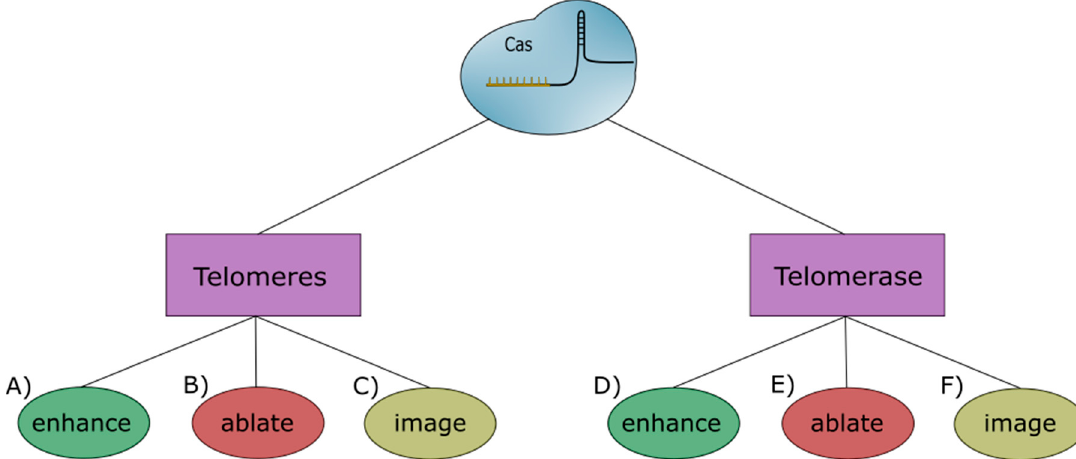
Figure 3. Overview of the uses for clustered regularly interspaced short palindromic repeats (CRISPR) in regards to telomeres and telomerase. Studies measuring an increase in telomere length (A) achieve this by activating telomere repair systems or increasing gene expression of proteins that build directly onto telomeres. As a whole, these studies observe normal to enhanced replicative capacity. Conversely, CRISPR-mediated ablation of telomeres occurs through direct removal and damage (B). These studies witness an upregulation of repair mechanisms as well as decreases in both cellular health and viability. Studies involved in imaging telomeres largely utilize fluorescently labeled dCas (C) and observe minimal cytotoxicity and high efficiency. These properties allow for real-time, in vivo study of telomere movements and interactions. Enhancing telomerase activity through interactions with other proteins and epigenetic changes (D) leads to increases in telomere length that can result in chromosomal instability. These changes can increase replicative capacity and led to cell phenotypes similar to cancer cell lines. The ablation of the telomerase gene occurs through direct action of the Cas protein or by activating genes that inhibit its transcription (E). Overall, these changes lead to a decrease in replicative capacity and/or an upregulation in alternate telomere lengthening mechanisms. Imaging telomerase involves directly introducing a fluorescent tag onto the TERT protein (F). This allows for the study of telomerase activity as well as the dynamics of telomere